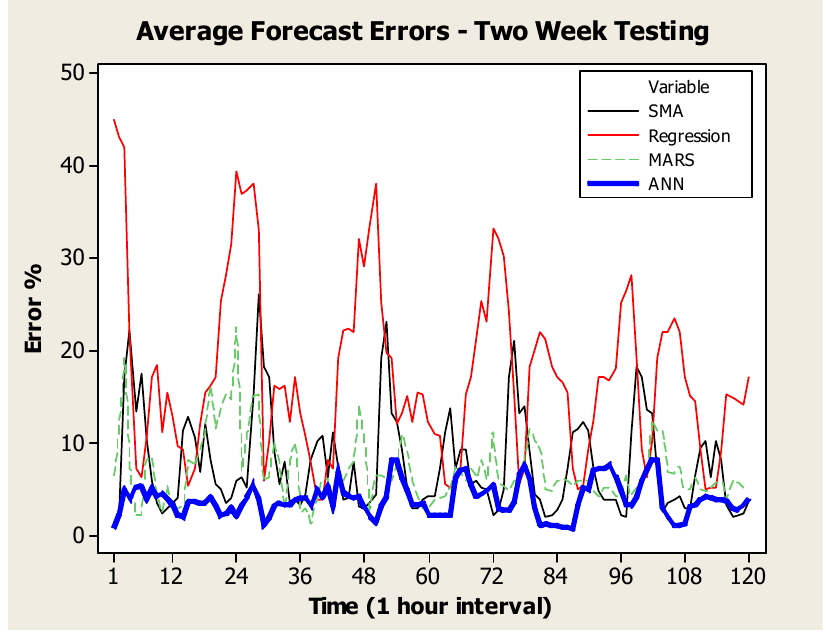
Figure 6. One week forecast errors predicted electrical kW demand vs. actual.